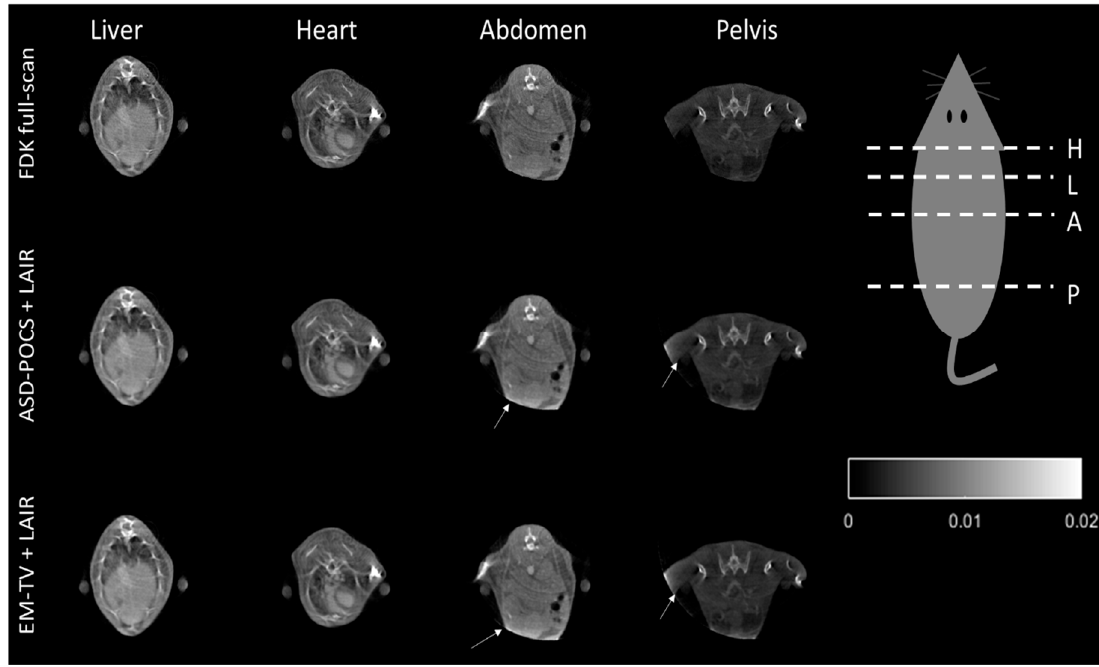
Figure 9. The tomographic images of the contrast-injected mouse, which cross over into the liver (L), heart (H), abdomen (A) and pelvis (P) regions, reconstructed using the conventional FDK and the two LAIR algorithms. The display is in the range of [0, 0.02].